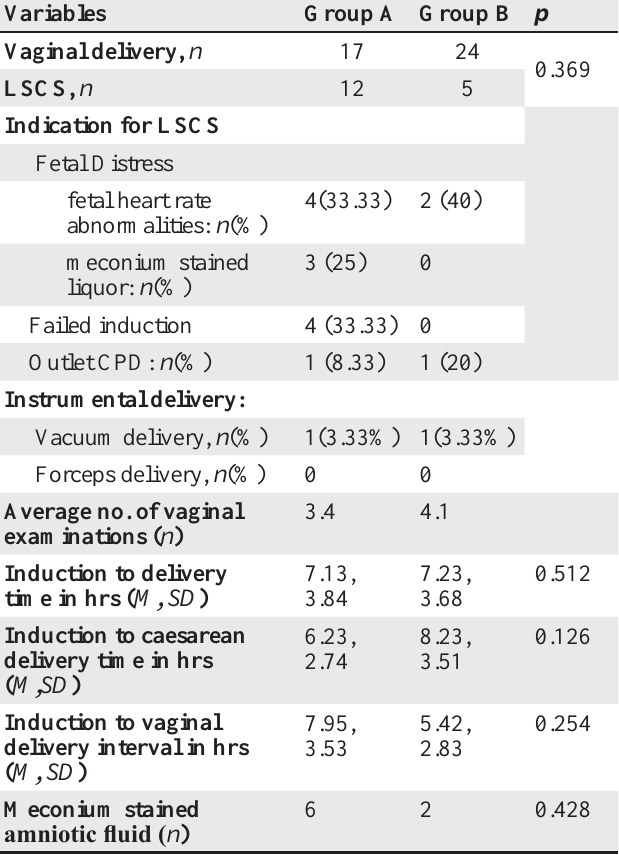
Table 3: Distribution of cases according to delivery details